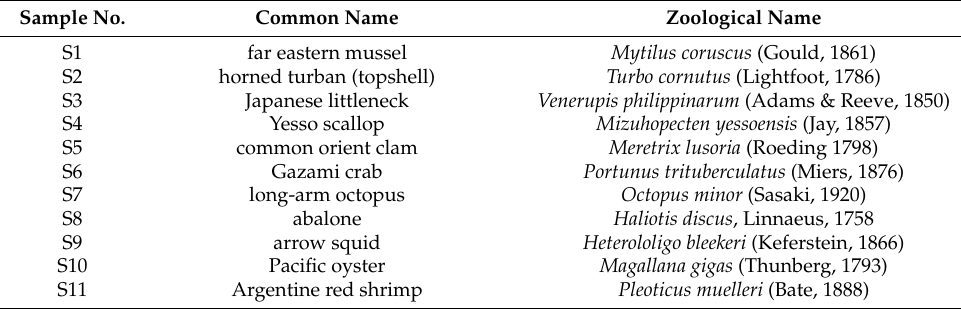
Table 1. List of shellfish species used in the present investigation. Sample